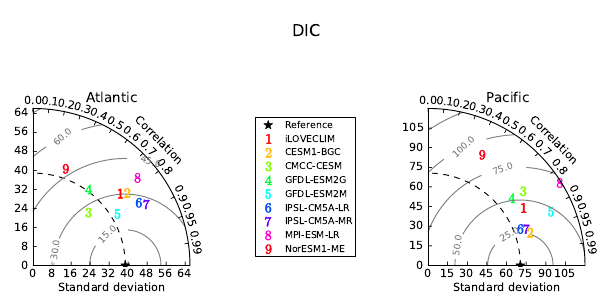
Figure 20. Comparison of the latitude–depth pattern of zonally av- eraged dissolved inorganic carbon in the Atlantic and Pacific basins (Taylor diagrams). Data from GLODAP (Key et al., 2004).